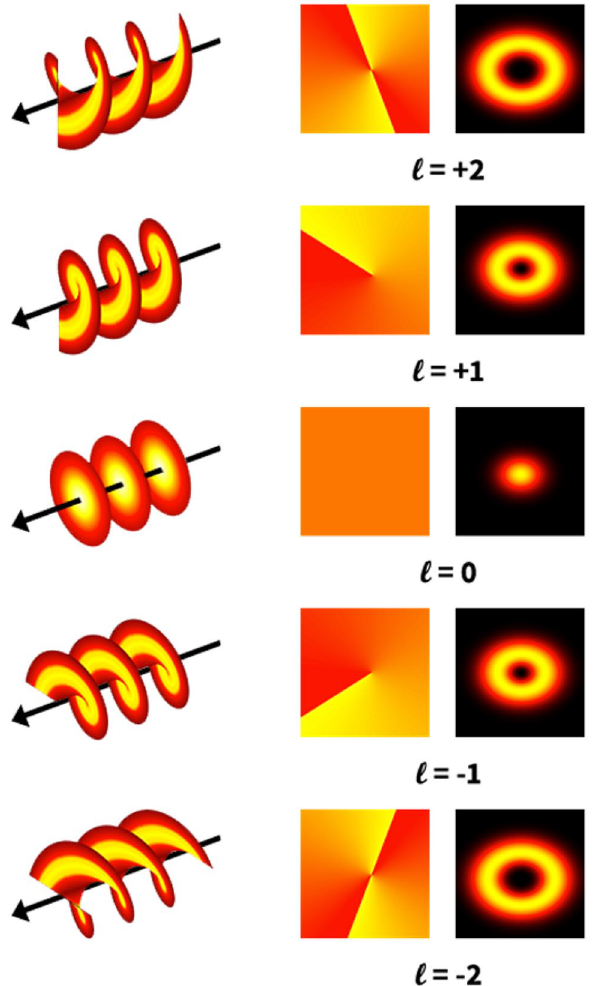
Figure 2. Different topological orders of OAM light beams. Columns left to right show the beam wave front, phase front and the intensity